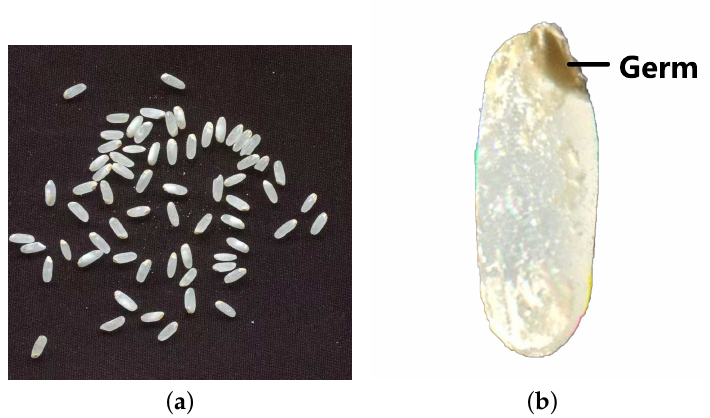
Figure 2. Collected images. ( a ) Full image. ( b ) Single germ rice.